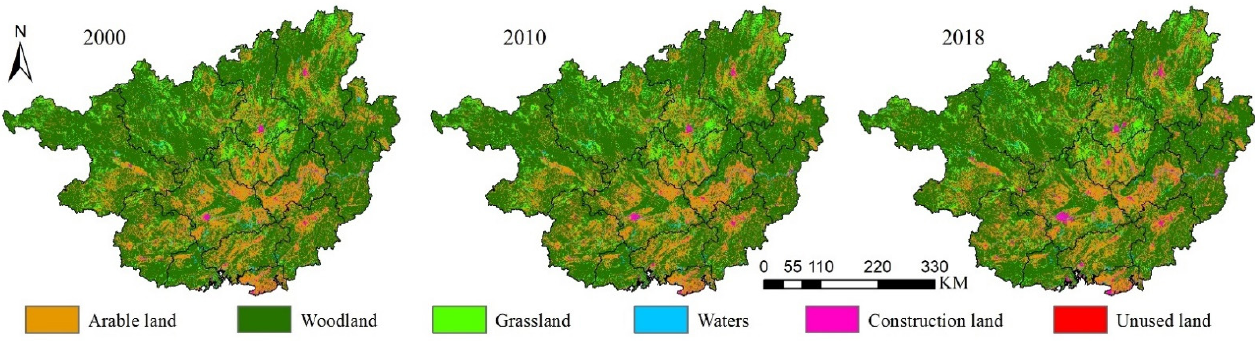
Figure 2. Land-use types in Guangxi.